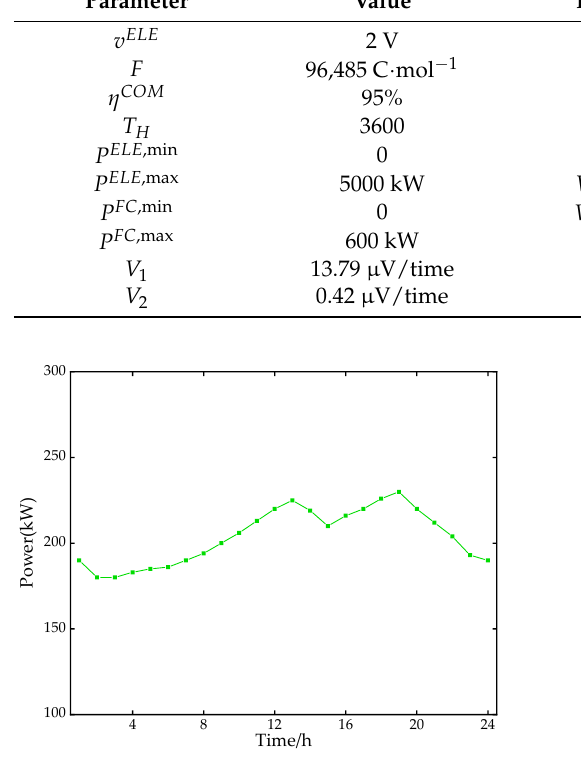
Figure 5. The fixed load of CES.